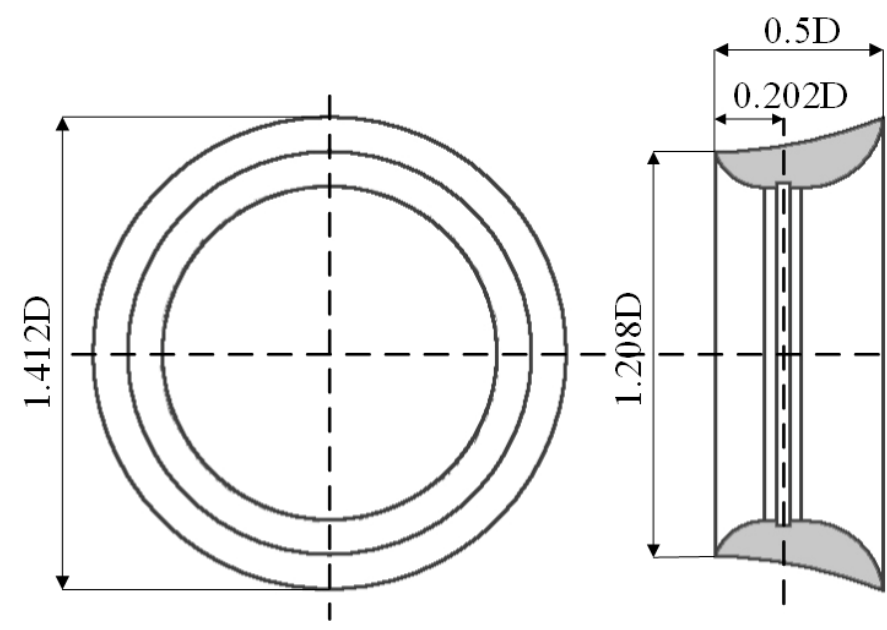
Figure 2. Dimension diagram of the duct.